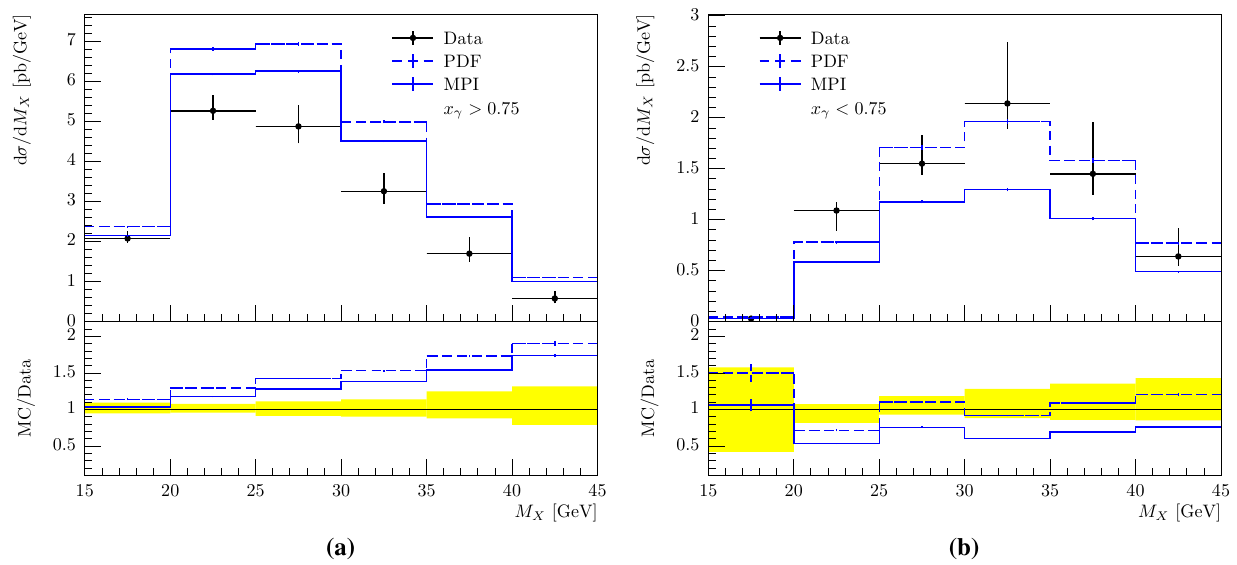
Fig. 8 The model with (solid lines) and without (dashed lines) gap survival compared to ZEUS data on M X in the direct-enhanced ( a ) and resolved-enhanced ( b ) regions